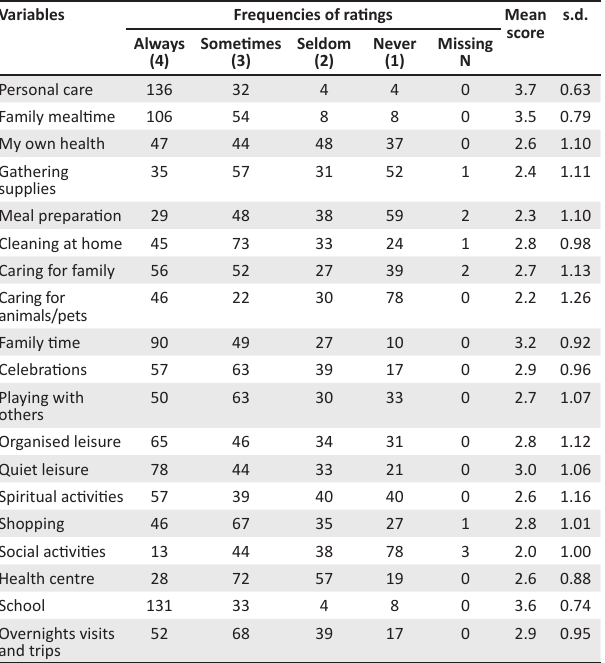
TABLE 2: Descriptive statistics of the principal component analysis based on all Picture My Participation items. Variables Frequencies of ratings Mean